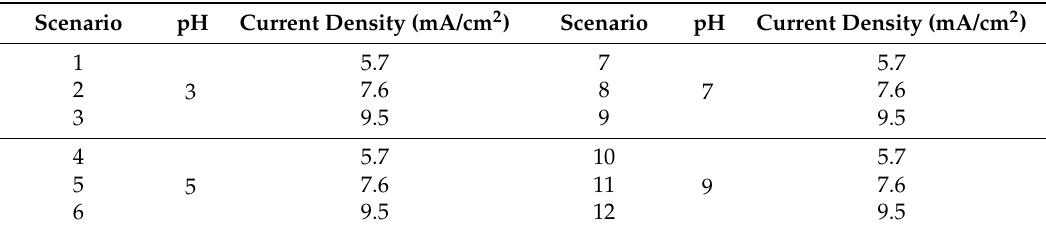
Table 1. pH and current density conditions for acetaminophen